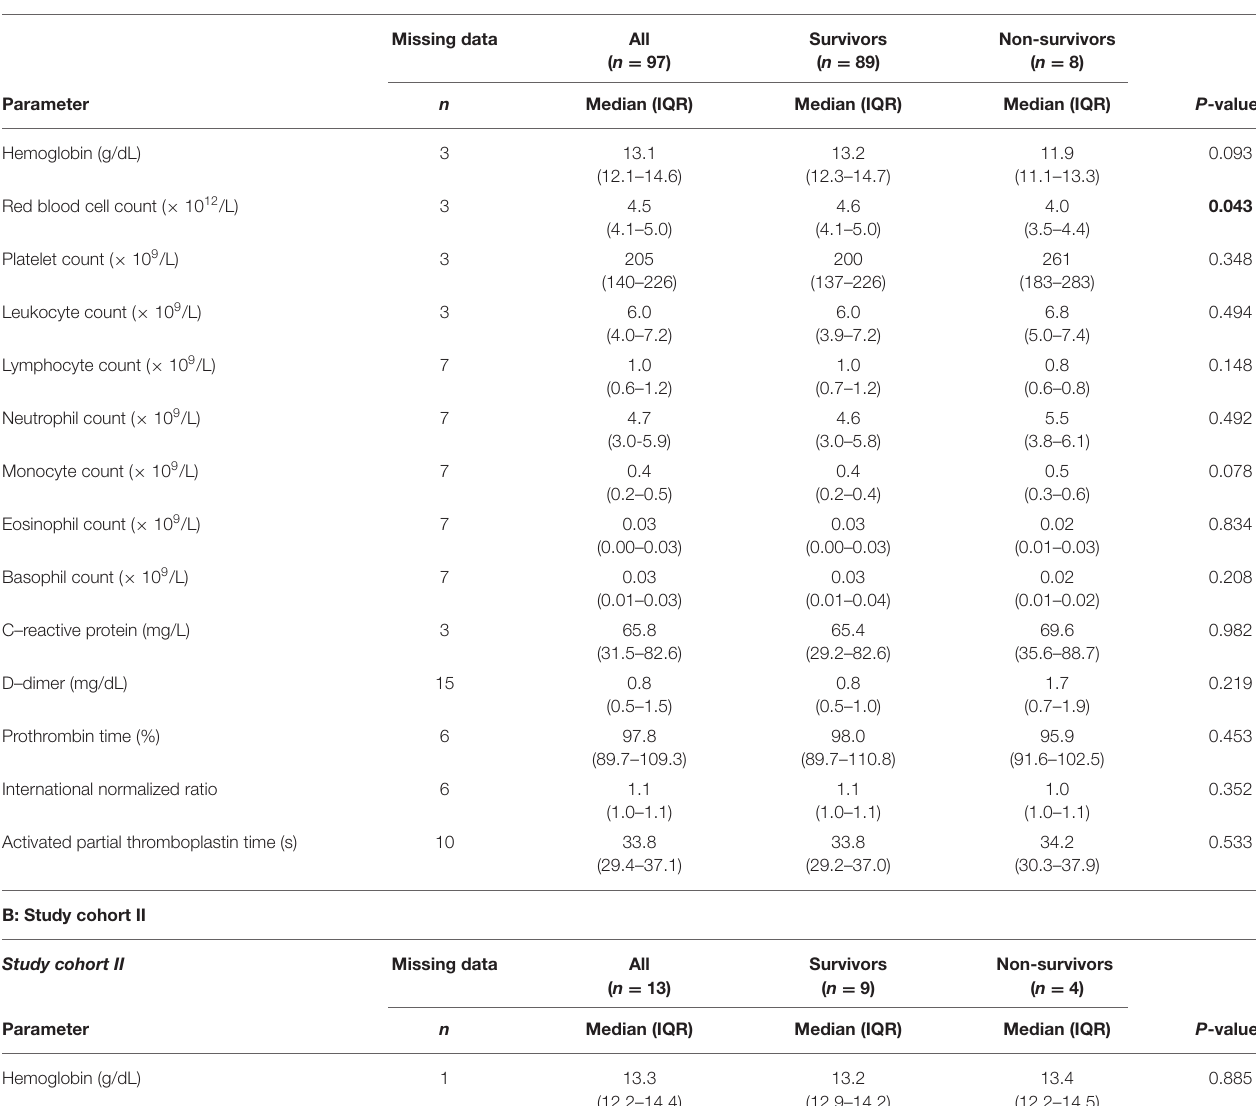
TABLE 2 | Laboratory findings at admission flow cytometric study cohort I (A) and proteomics cohort II (B)